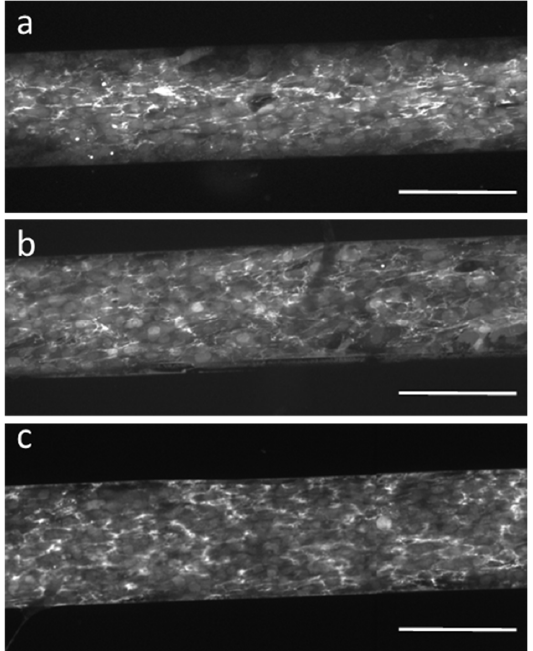
Figure 7. Immunocytochemical staining visualizing secretion of full-length fibronectin by GFP- transfected human fibroblasts (HF-GFP) proliferating on ( a ) FnIII9-10-, ( b ) FnIII10- and ( c ) Fn-modified biochip surfaces, respectively. The scale bar is 200 µm.